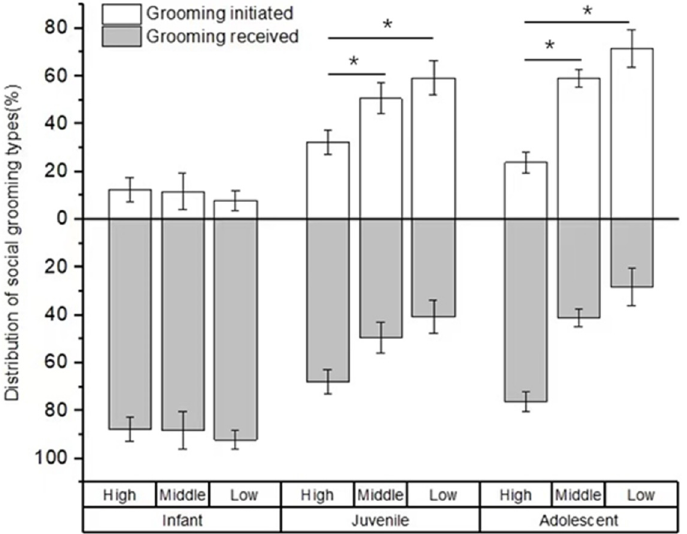
Figure 5. The percentage of grooming types among immature individuals with mothers of different rank categories. High, middle, and low refer to the social rank of immatures’ mothers (* p < 0.05). Furthermore, as indicated in Figure 6, immature individuals with high-ranking mothers initiated 66.15 ± 4.80% of social grooming with immature individuals with high-ranking mothers, 20.89 ± 1.93% with those with middle-ranking mothers, and 12.96 ± 4.35% with those with low-ranking mothers ( χ 2 = 7.209, p = 0.027). Immature individuals with middle-ranking mothers initiated 63.01 ± 3.59% of social grooming with immature individuals with high-ranking mothers, 21.91 ± 3.61% with those with middle-ranking mothers, and 15.08 ± 3.52% with those with low-ranking mothers ( χ 2 = 8.782, p = 0.012). Immature individuals with low-ranking mothers initiated 47.54 ± 4.67% of social grooming with immature individuals with high-ranking mothers, 38.05 ± 2.58% with those with middle-ranking mothers, and 14.41 ± 3.01% with those with low-ranking mothers ( χ 2 = 8.103, p =